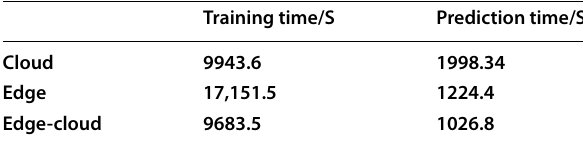
Table 7 Model performance using edge